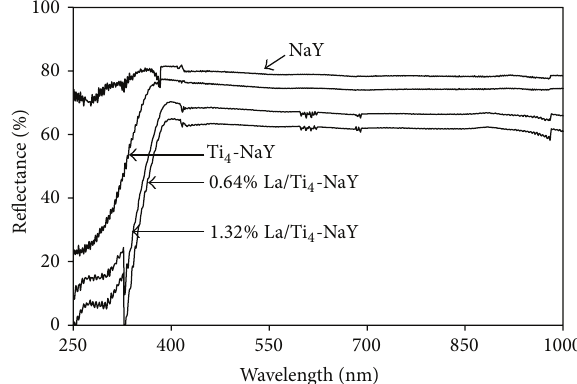
Figure 3: The reflection spectra for different